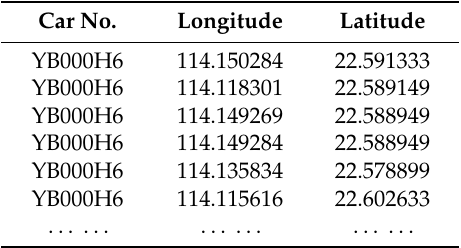
Table 12. GPS data format after optimization